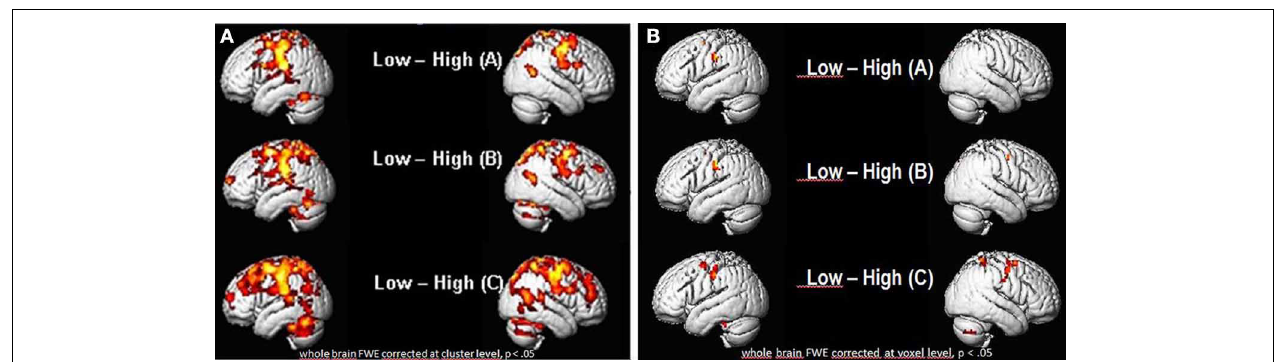
(B) FWE corrected (whole brain) for multiple comparisons at voxel level, p < 0 . 05. Significant differences in activation already found for (A) reading in mother tongue, with increasing activations in speech-related areas the more complex the reading task gets (reading English sentences and German sentences with fake English accent). Activation peak observed in the left inferior parietal (IPL) cortex, supramarginal